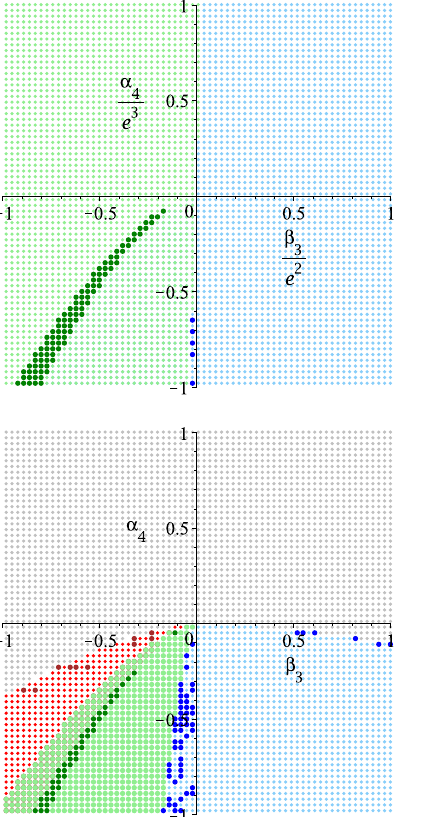
Figure 6 . Number of critical points as a function of couplings in d = 5 (colour online). Top Left : for k = 1 and e = 1 we see a broad (green) region in ( (cid:12) 3 ; (cid:11) 4 ) parameter space having only one physical critical point with a band (dark green) where two physical critical points exist. There are two and single critical point with (cid:13) 2 < 0 in the dark blue and blue regions. Top right : for k = (cid:0) 1 and e 2 = 0 : 1 the only region having (single) physical critical points is the green band in the lower-left quadrant; the light brown region has a single critical point with an unphysical imaginary asymptotic value for f 1 ; the grey regions do not have critical points, and in the white region the mass is negative. Bottom left : for k = 1 ; e = 0, the brown and red points respectively demonstrate the existence of one and two critical points with S < 0; Bottom right : for k = (cid:0) 1 ; e = 0, there is still an allowed region (green) of physical critical points; in the white region the mass is